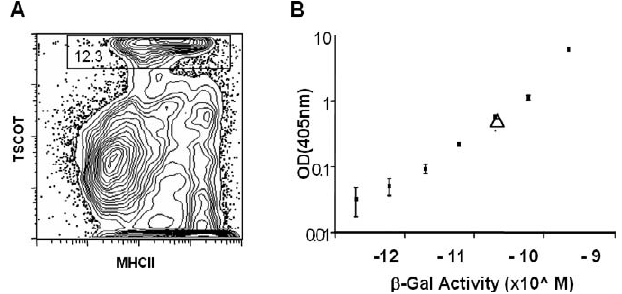
Figure 3. Estimation of the Number of LacZ Molecules Expressed in the TSCOT-Expressing Cells (A) Flow cytometric analysis of the percentage of TSCOT-expressing cells in the thymus preparation. (B) Standard curve of b -gal enzyme activity using purified LacZ protein. The purified LacZ enzyme from the commercial source was measured by the weight, and the stock enzyme solution was diluted serially to generate the curve. The open triangle indicates the measured value for a protein extract generated from 30 TDLacZ homozygous ( D / D ) thymuses.